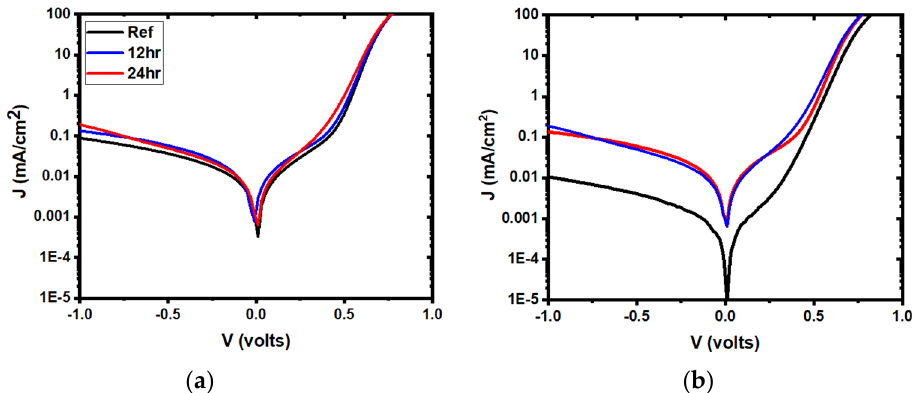
Figure 6. Representative density-voltage (J-V) and quantum efficiency (QE) curves for 3 mTorr samples ( a , b ) and 5 mTorr samples ( c , d ), for reference (black) and water-soaked (12 h: blue, 24 h: red) devices.